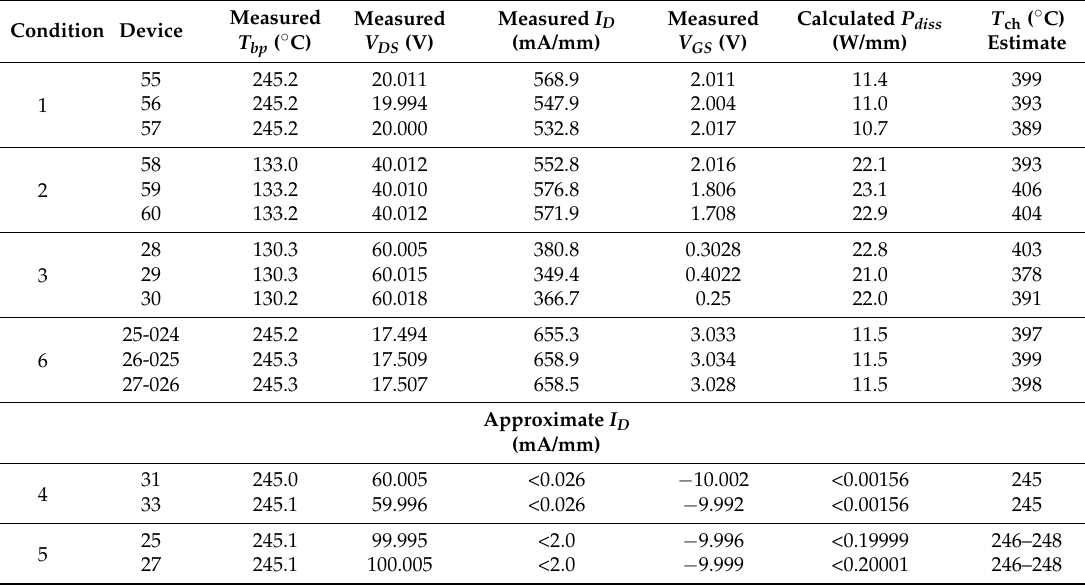
Table 1. Initial measured parameter